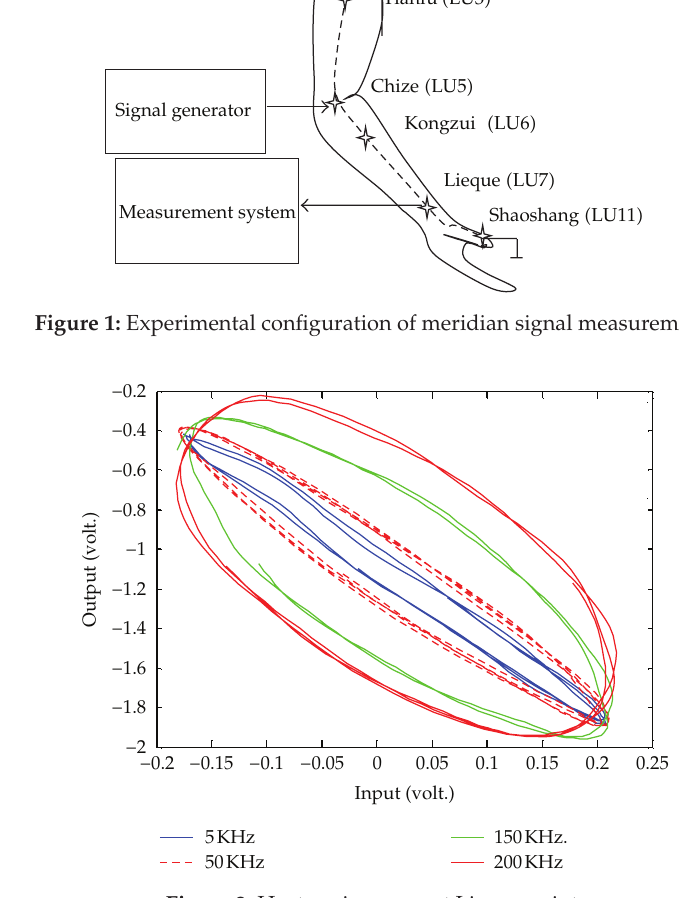
Figure 2: Hysteresis curves at Lieque